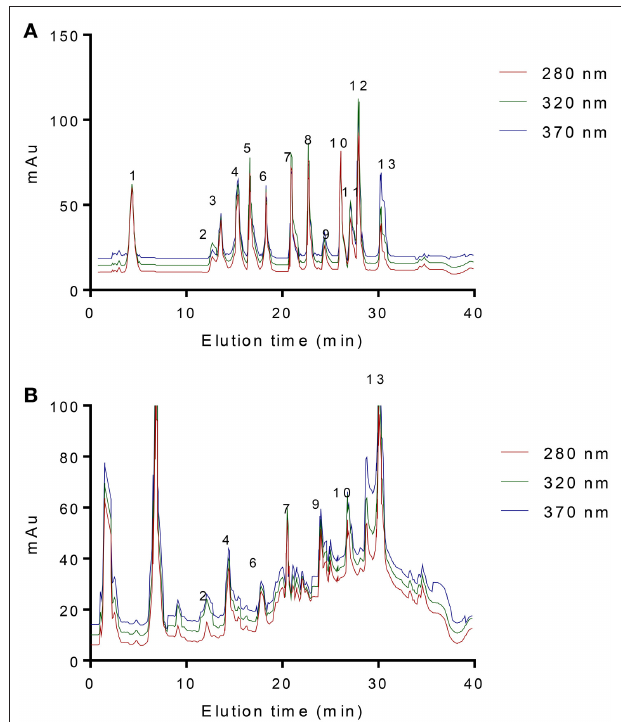
FIGURE 2 | HPLC analysis of blueberry compounds. (A) phenolic acid standards mixture, 1 gallic acid, 2 gentisic acid, 3 (1)-catechin, 4 chlorogenic acid, 5 caffeic acid, 6 (2)-epicatechin, 7 p-coumaric acid, 8 sinapic acid, 9 benzoic acid, 10 p-anisic acid, 11 myricetin, 12 3,4,5-trimethoxycinnamic acid and 13 quercetin. (B) compounds from blueberry juice. 2 gentisic acid, 4 chlorogenic acid, 6 (2)-epicatechin, 7 p-coumaric acid, 9 benzoic acid, 10 p-anisic acid and 13 quercetin. The detection wavelength was set at three different UV wavelengths, 280, 320, and 370nm.